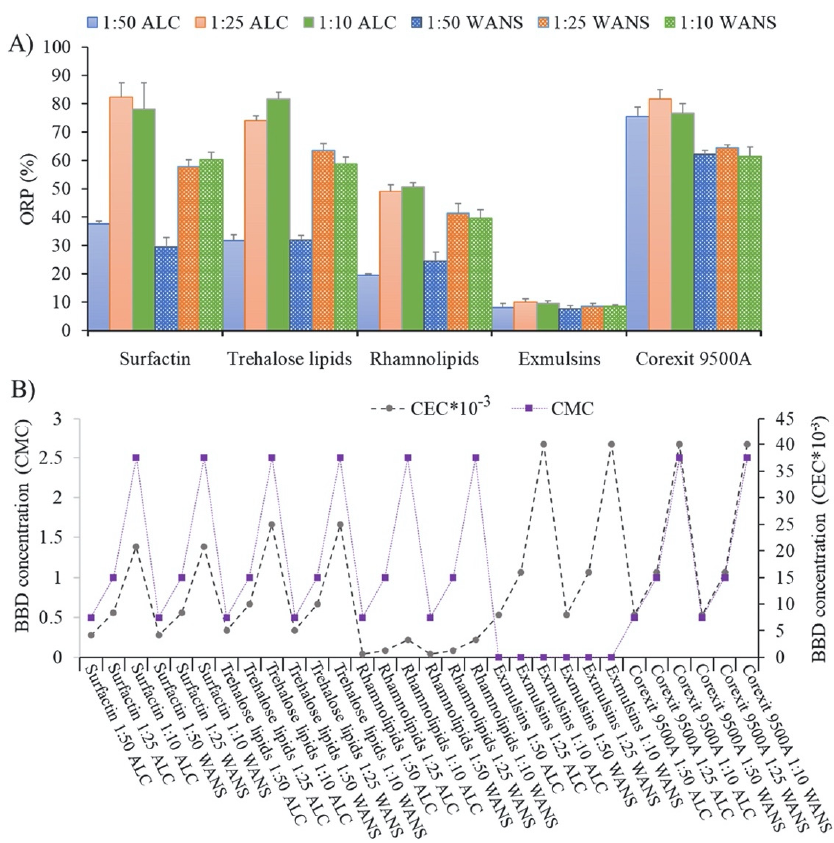
Figure 8. Oil dispersion effectiveness of BBDs. ( A ) ORP (oil-removal performance) (%) of various BBDs used at three DORs (dispersant-to-oil ratios) against ALC (Arabian light crude oil) and WANS (weathered Alaska North Slope crude oil) in BFT (Baffled Flask Test); ( B ) concentrations of BBDs in terms of unit CMC (critical micelle concentration) or unit CEC (critical emulsion concentration) in each BFT [74]. (Copyright 2016 Elsevier